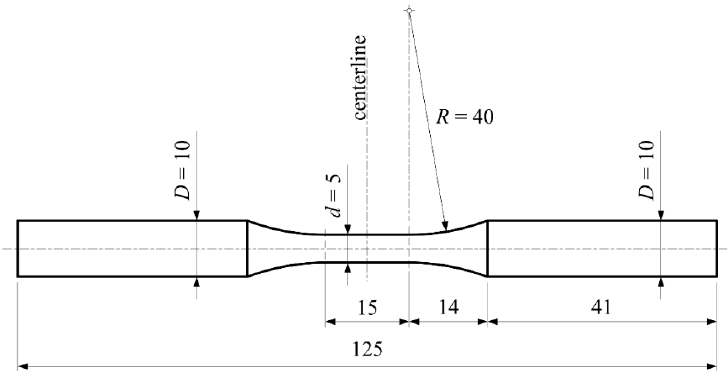
Figure 11. Specimen’s geometry-fatigue test.